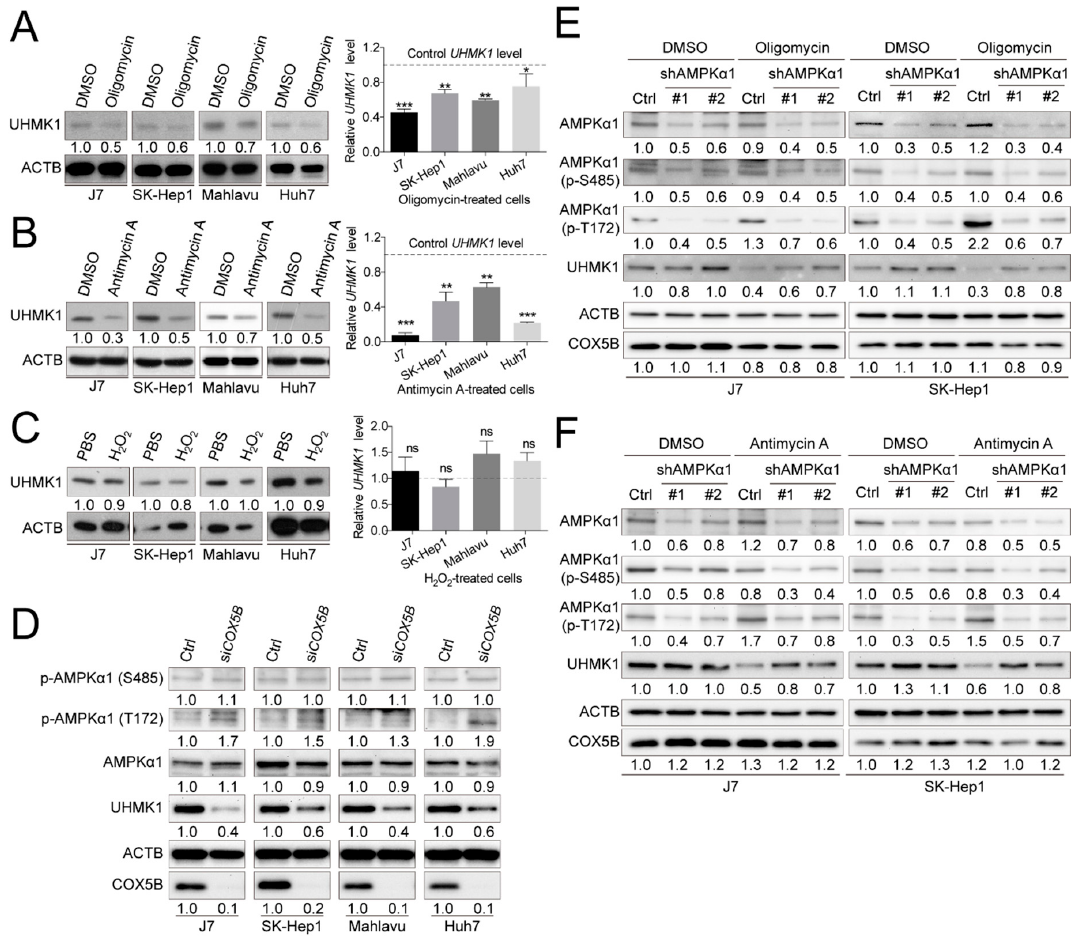
Figure 6. COX5B-mediated bioenergetic alteration modulating UHMK1 expression is AMPK activation-dependent. Western blot and RT-qPCR analysis of cell lysates derived from cells treated with ( A ) oligomycin, ( B ) antimycin A and ( C ) H 2 O 2 . Oligomycin and antimycin A were used for blocking bioenergy production. H 2 O 2 was used for accumulating ROS. The western blot images in this panel were acquired by exposing the luminescent signals to x-ray films, except for those of the Antimycin-treated Mahlavu cell, which was obtained by using chemStudio PLUS imaging system. The p value was derived from paired two-tail student t -test. *, p < 0.05; **, p < 0.01; ***, p < 0.001; ns, not significant. ( D ) The relationship between depletion of COX5B and activation of AMPK was assessed by western blot. AMPK T172 phosphorylation indicated activation while S485 phosphorylation was considered suppression of enzyme activities. The combined analysis of the relationship between bioenergetic alteration, induction by ( E ) oligomycin and ( F ) antimycin A, and activation of AMPK in modulation of UHMK1 expression. The western blot images in ( D-F ) were all acquired by using chemStudio PULS imaging system. All the in vitro cell-based assays shown in this figure were conducted in duplicates. 2.6. COX5B-UHMK1 Axis Modulates Cell Proliferation and Migration in Hepatoma